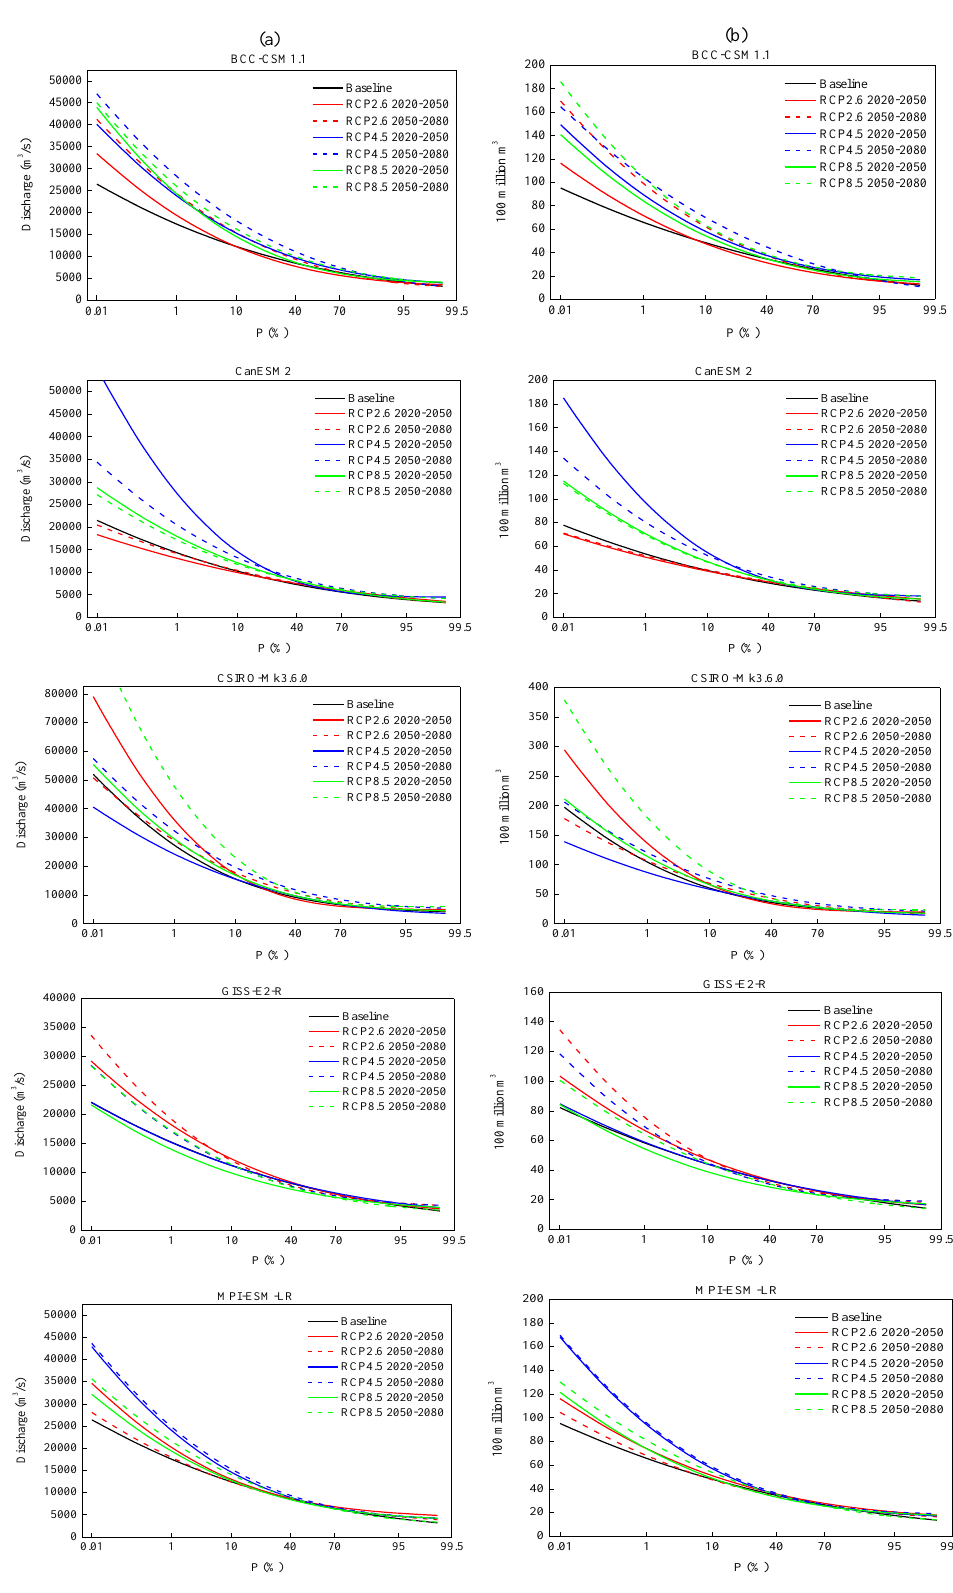
Figure 7. P-III frequency distributions of (a) AMX1d and (b) AMX7fv under different emission scenarios during two different future